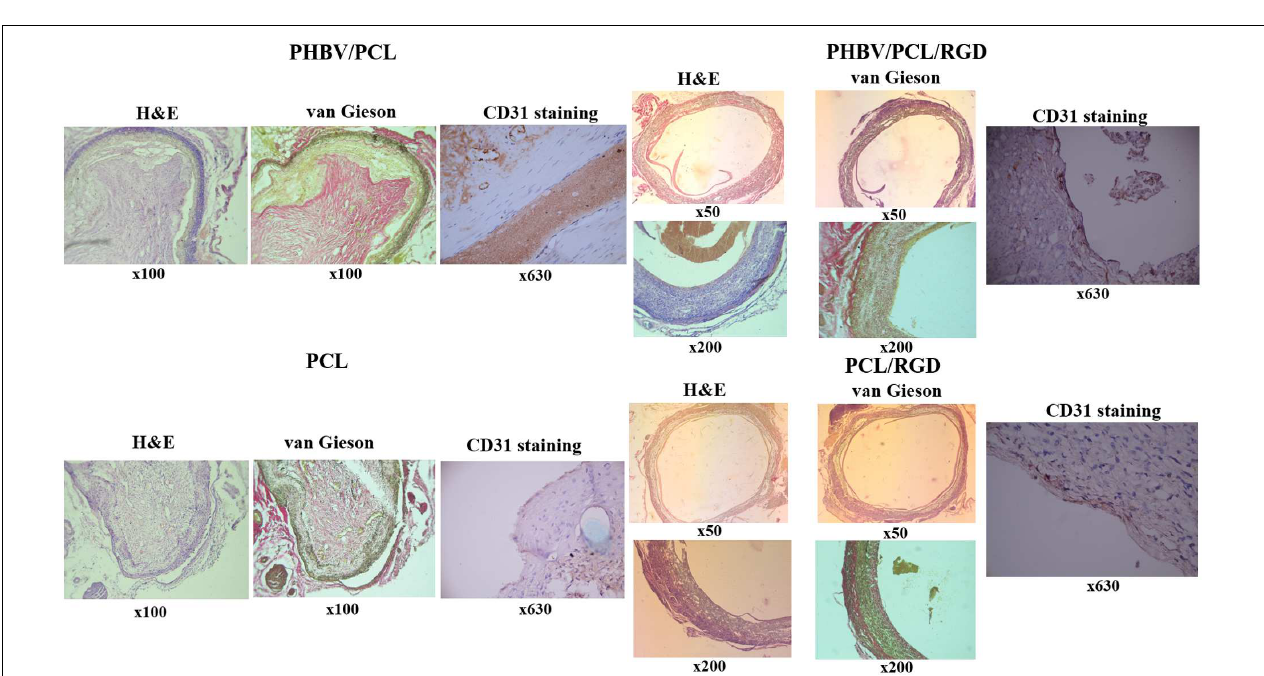
FIGURE 6 | Modification of PHBV/PCL and PCL vascular grafts with RGD peptides enhances formation of endothelial cell monolayer. H&E and van Gieson staining revealed a putative endothelial cell monolayer on PHBV/PCL and PCL grafts with RGD peptides but not on those without; this was further confirmed by CD31 staining, which identified a monolayer of CD31-positive cells (brown) at the inner surface of both polymer grafts with RGD peptides.